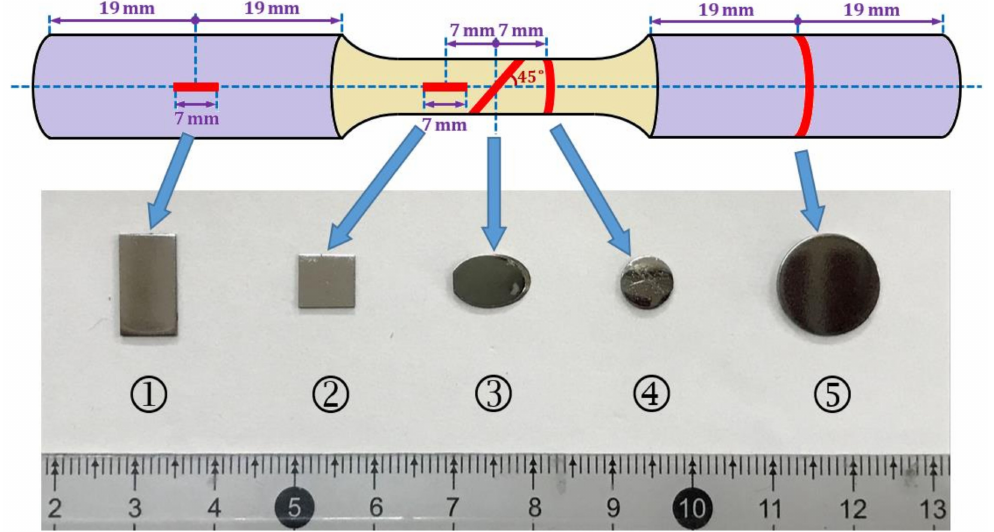
Figure 3. EBSD observational plane with various angles to loading axis in interrupted Sample